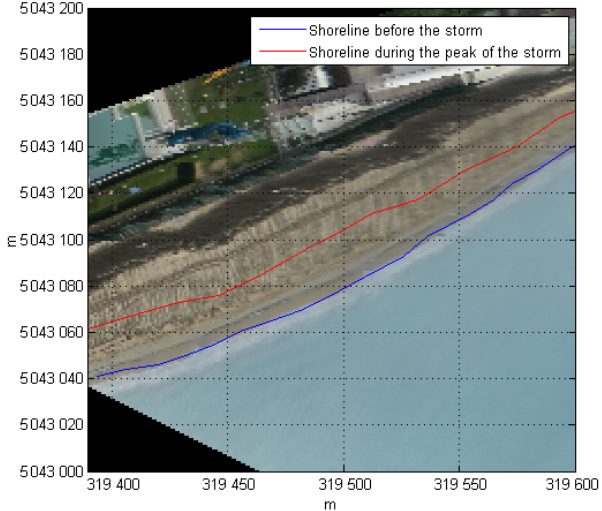
Figure 9. Detected shorelines, before and after the 14th storm, an example of the rotation of the beach.